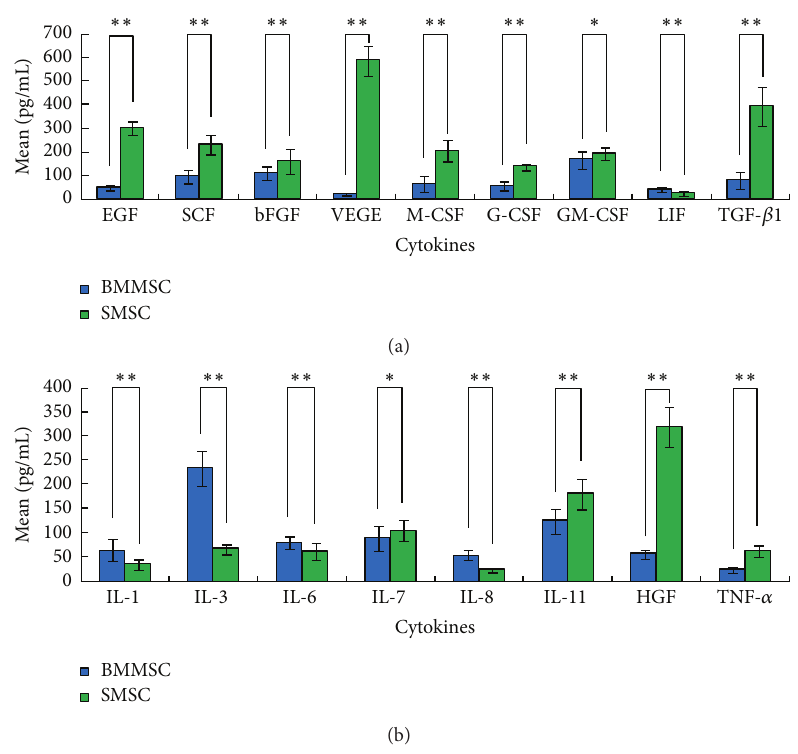
Figure 4: Cytokine levels in the culture medium of bone marrow mesenchymal stem cells (BMMSCs) and skin mesenchymal stem cells (SMSCs). (a) Cell proliferative cytokines. (b) Inflammatory cytokines. Cytokines from BMMSCs are indicated in blue; cytokines from SMSCs are indicated in green. ∗ 𝑝 < 0.05 ; ∗∗ 𝑝 < 0.01 .